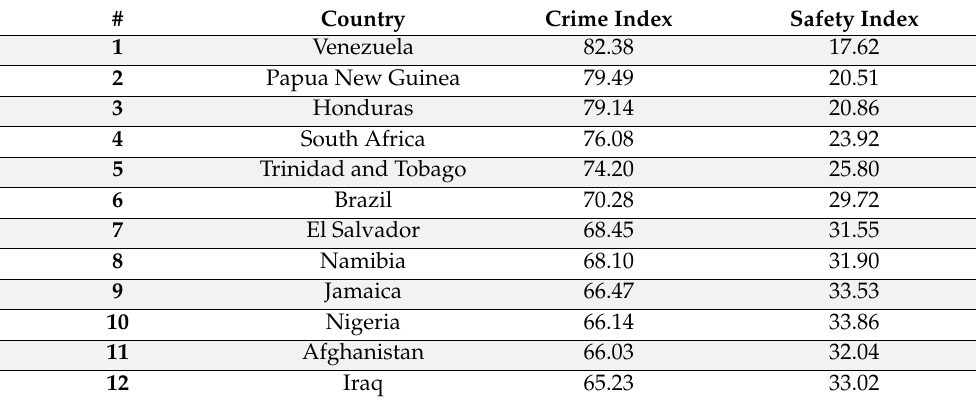
Table 1. Crime and Safety Index Ranking of Countries (Data source: [62] and authors’ own calculation).